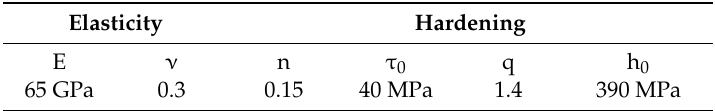
Table 1. Material parameters.